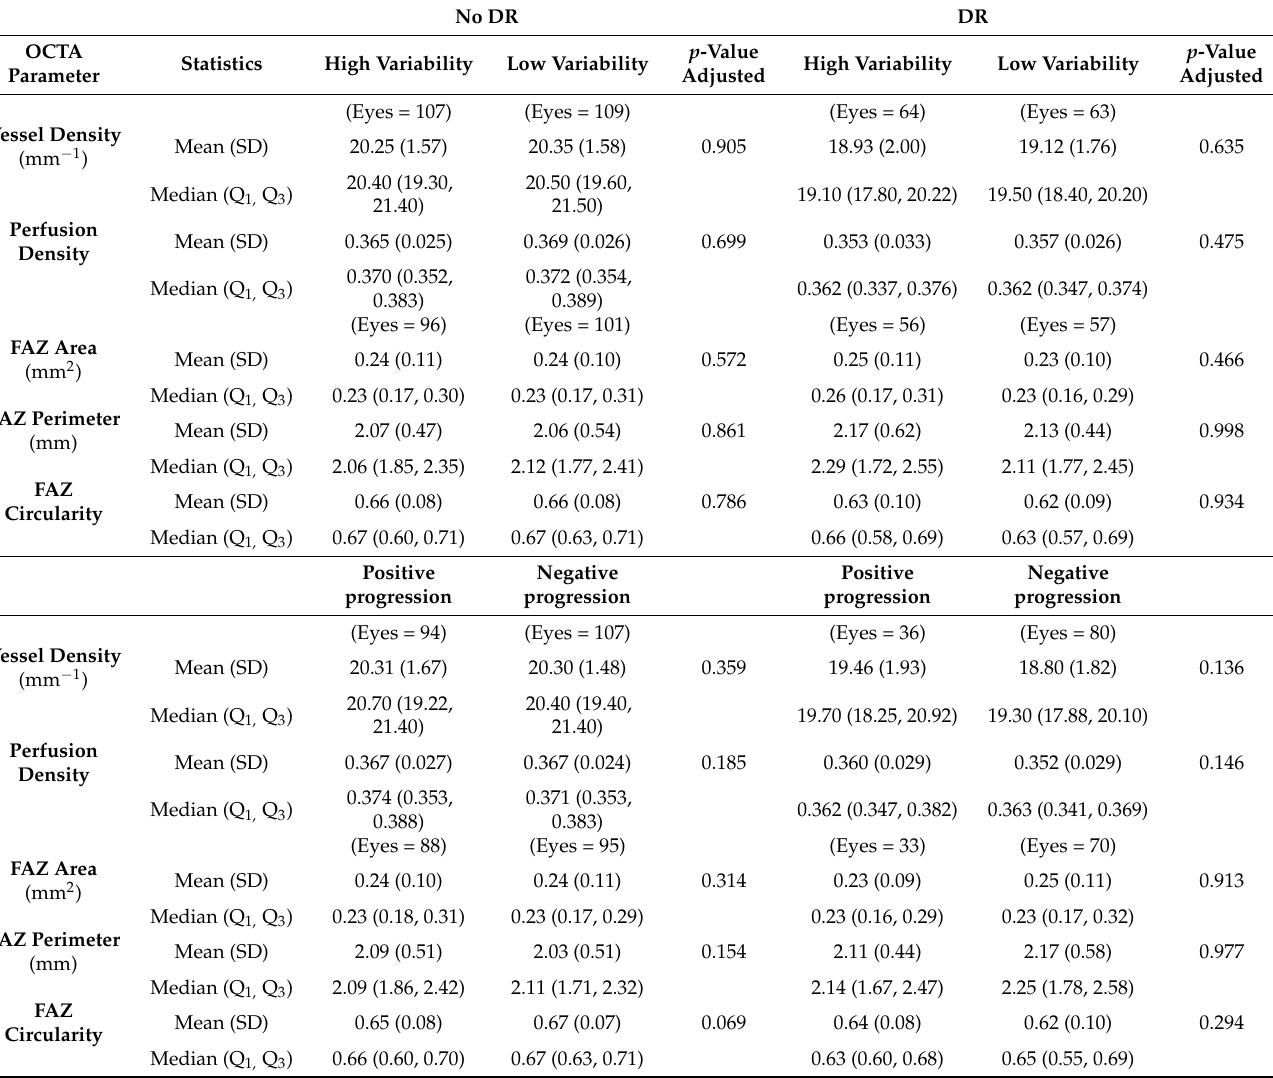
Table 3. Influence of 5-years HbA1c variability and progression on Optical coherence tomography angiography (OCTA) parameters. Subgroup analysis by DR status. ( p -value adjusted by age, sex, scan quality, diabetes mellitus duration, and axial